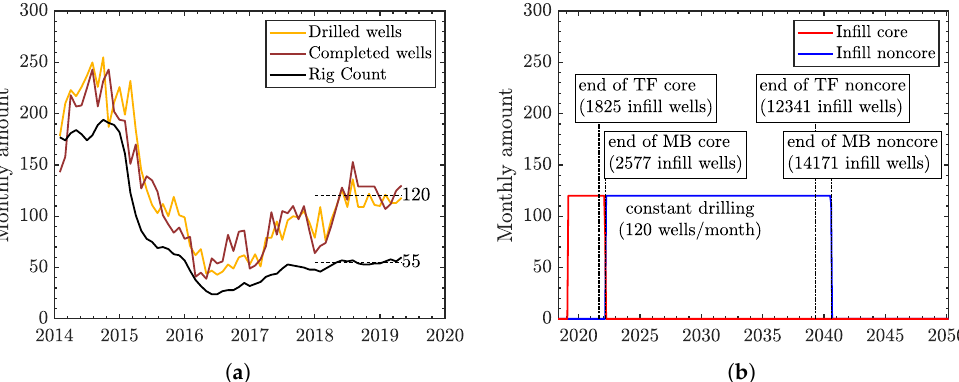
Figure 9. ( a ) The number of drilled wells, completed wells and rig count per month for the Bakken play from the U.S. Energy Information Administration (EIA). The drilled and completed wells are almost the same for each month and are strongly correlated with the number of rigs available. These data reveal an increase in drilling efficiency. In 2015, one rig could drill about 1.2 wells per month, while in 2019 so far, one rig could drill two wells per month. The current drilling rate is constant at about 120 wells/month. ( b ) A future drilling scenario for the Bakken region up to 2041. The plan is to continue at the current drilling rate of 120 wells/month for both core and noncore areas. The numbers of wells to be show that the core areas will be fully drilled by mid 2022, leaving the less productive noncore areas